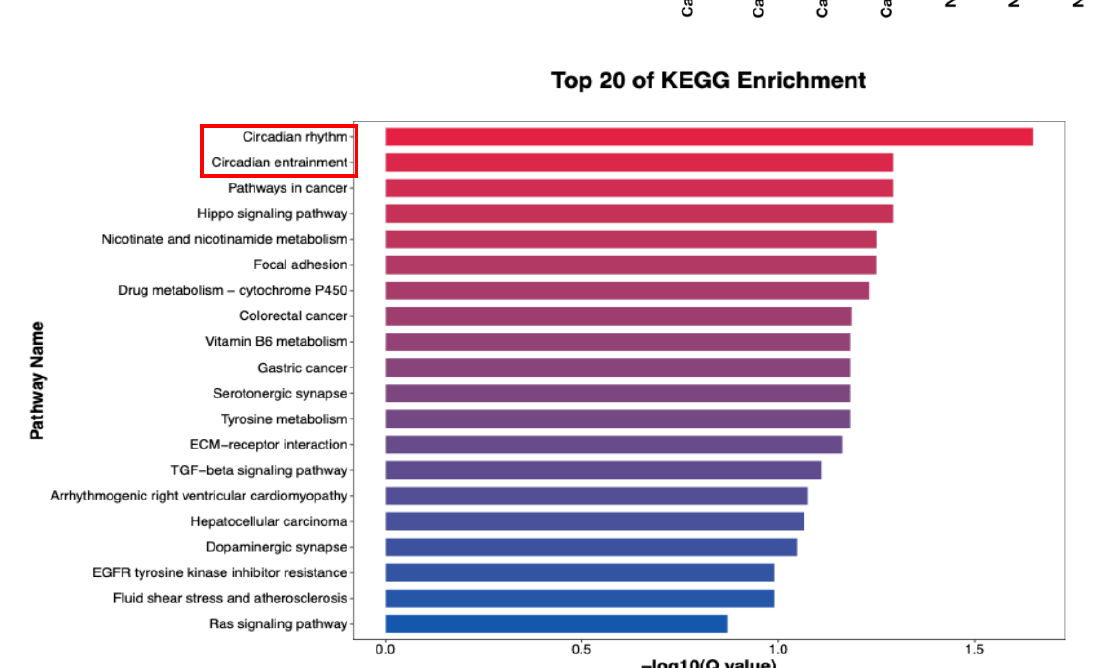
Figure 2. RNA seq of HVICs treated with normal and osteogenic medium. ( A ) gene expression profile with RNA-seq of HVICs treated with normal and osteogenic medium, where 221 upregulated genes and 143 downregulated genes were detected; ( B , C ) circadian rhythm and entrainment were top two pathways of KEGG enrichment and BMAL1 was one of the related genes.